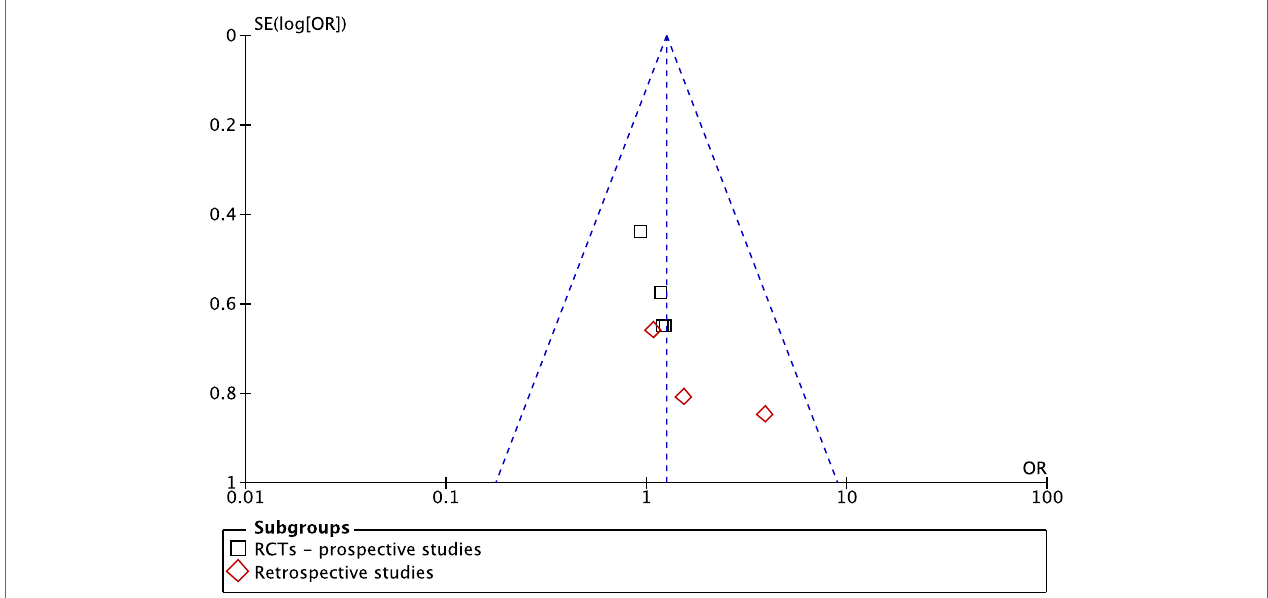
FigUre 3 | Funnel plot of comparison: preputioplasty vs. circumcision for the outcome hypospadias fistula formation